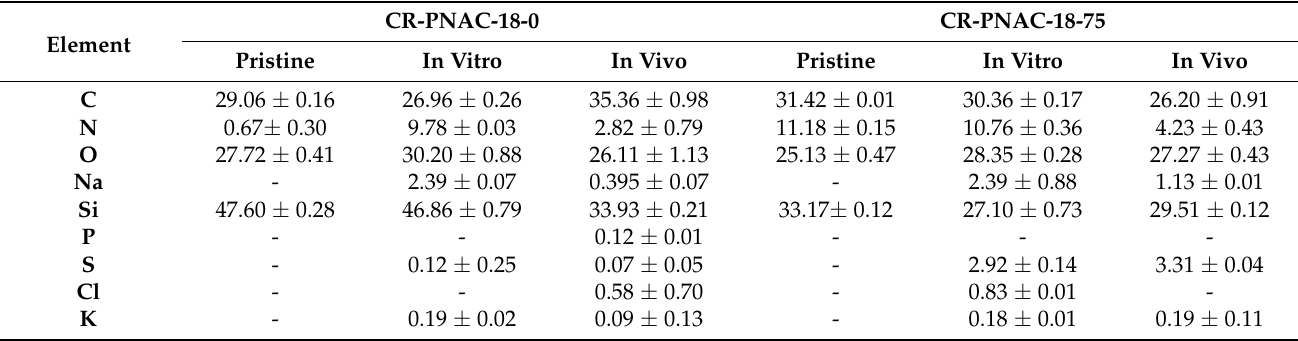
Table 1. SEM/EDX composition of CR-PNAC-18-0 and CR-PNAC-18-75 samples before and after in vitro and in vivo tests.